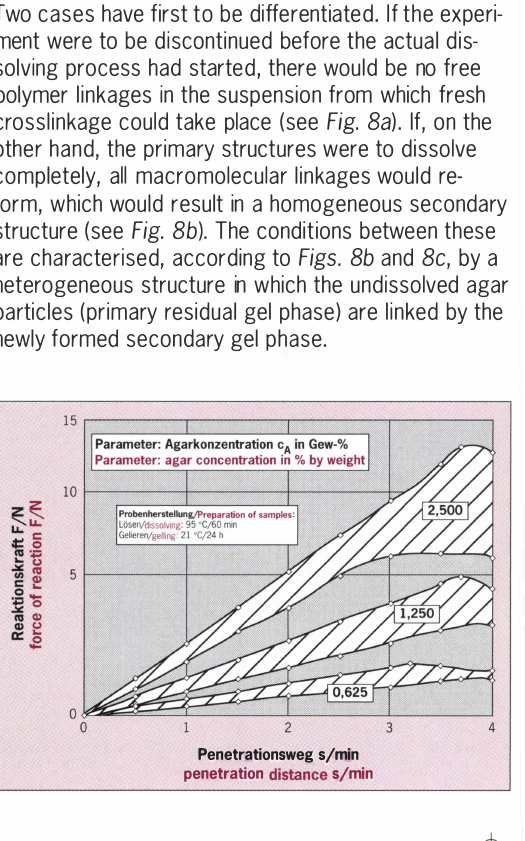
Fig. 7: Penetration curves for agar ;water gels of different